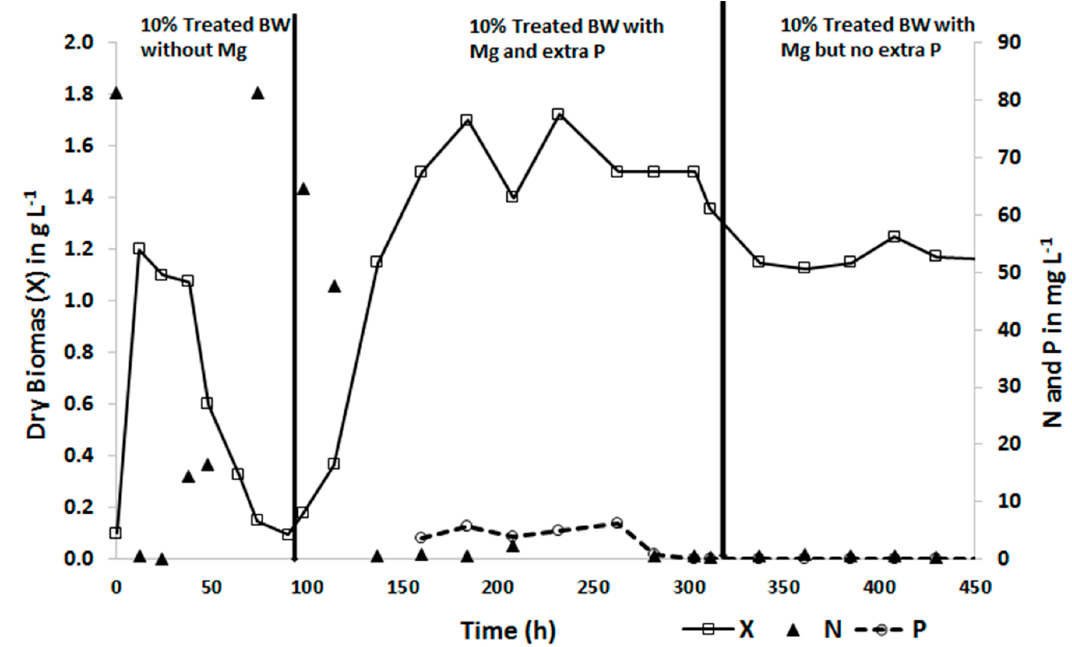
Figure 4. Dry biomass concentration X in g L − 1 without Mg and without extra P, with Mg and extra P and with Mg but not extra P ( □ ), N concentration in the effluent ( ▲ ), and P concentration in the effluent (-o-) using 10% treated source-separated blackwater as a substrate.